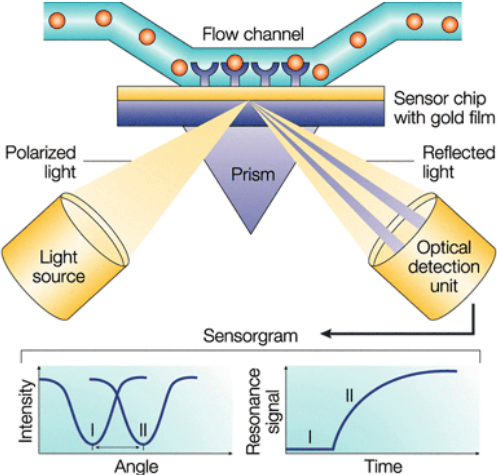
Figure 3. Setup of a microfluidic SPR biosensor. Reprinted by permission from